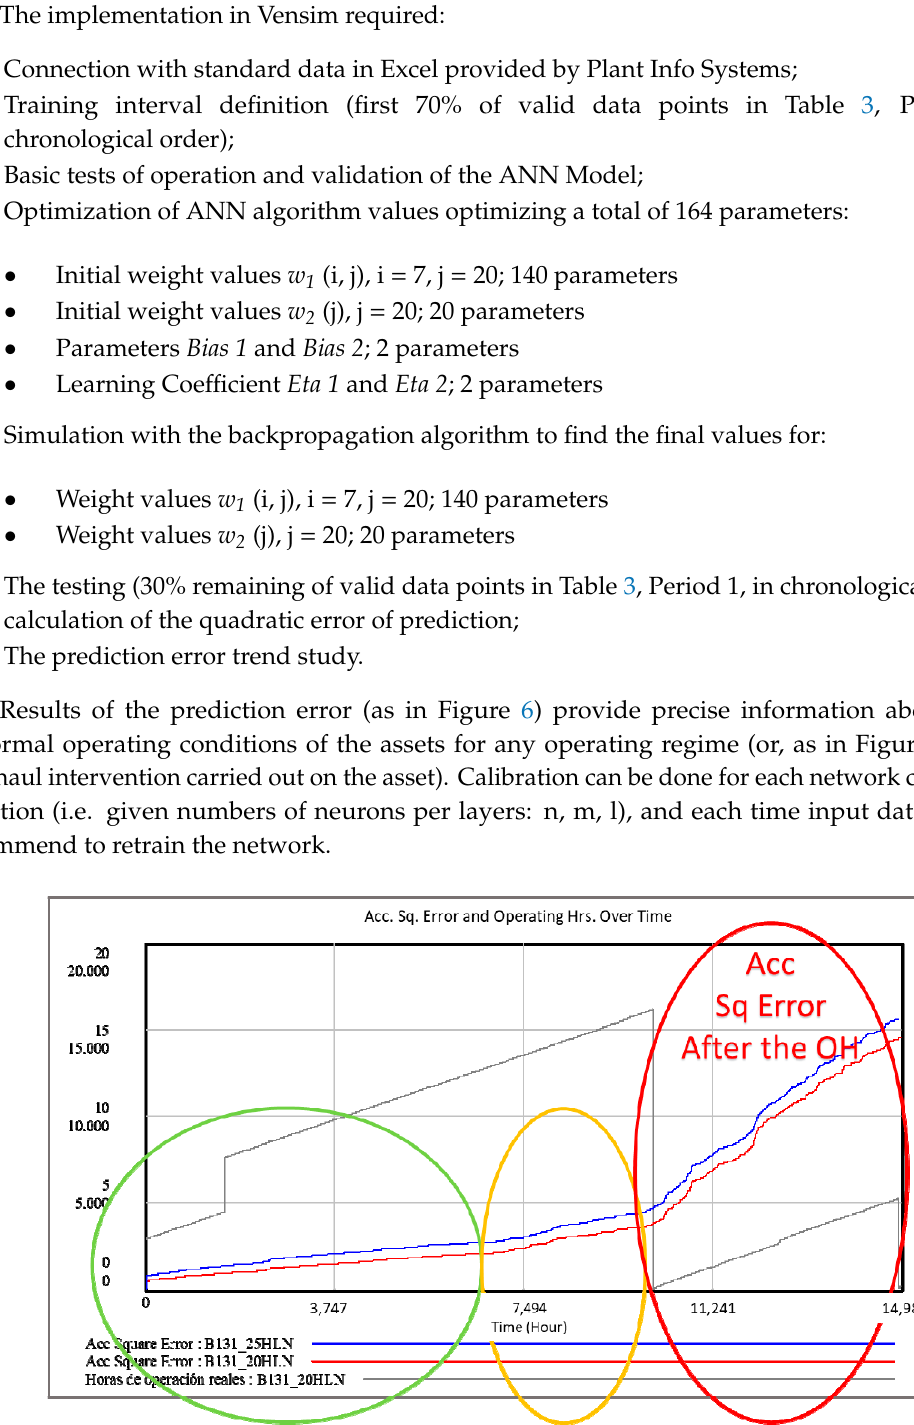
Table 5. Artificial Neural Network (ANN) algorithm results for the regression problem (with 20 N/HL). Metric